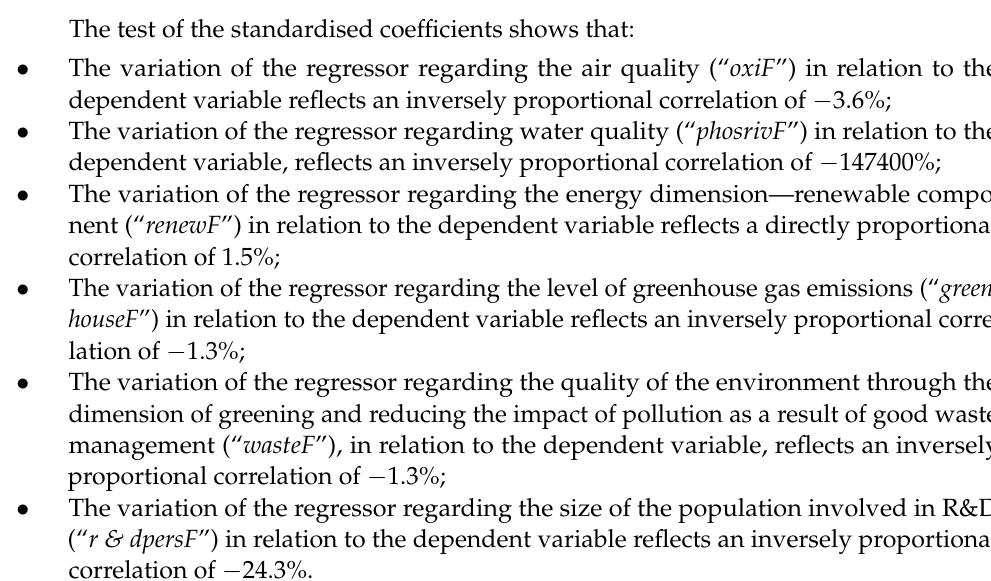
Figure 7. Regression analysis for France during 2000–2020. Source: Data operated under IBM-SPSS 25 (IBM, Armonk, NY, USA).